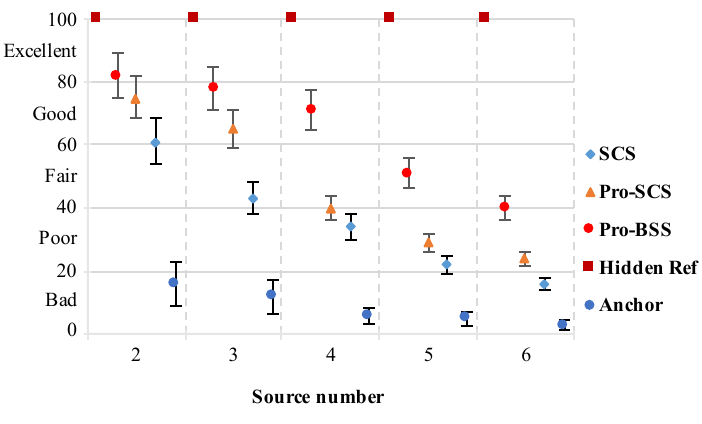
Figure 14. MUSHRA test results of separation = 40 ◦ . Error bars with 95% confidence intervals.